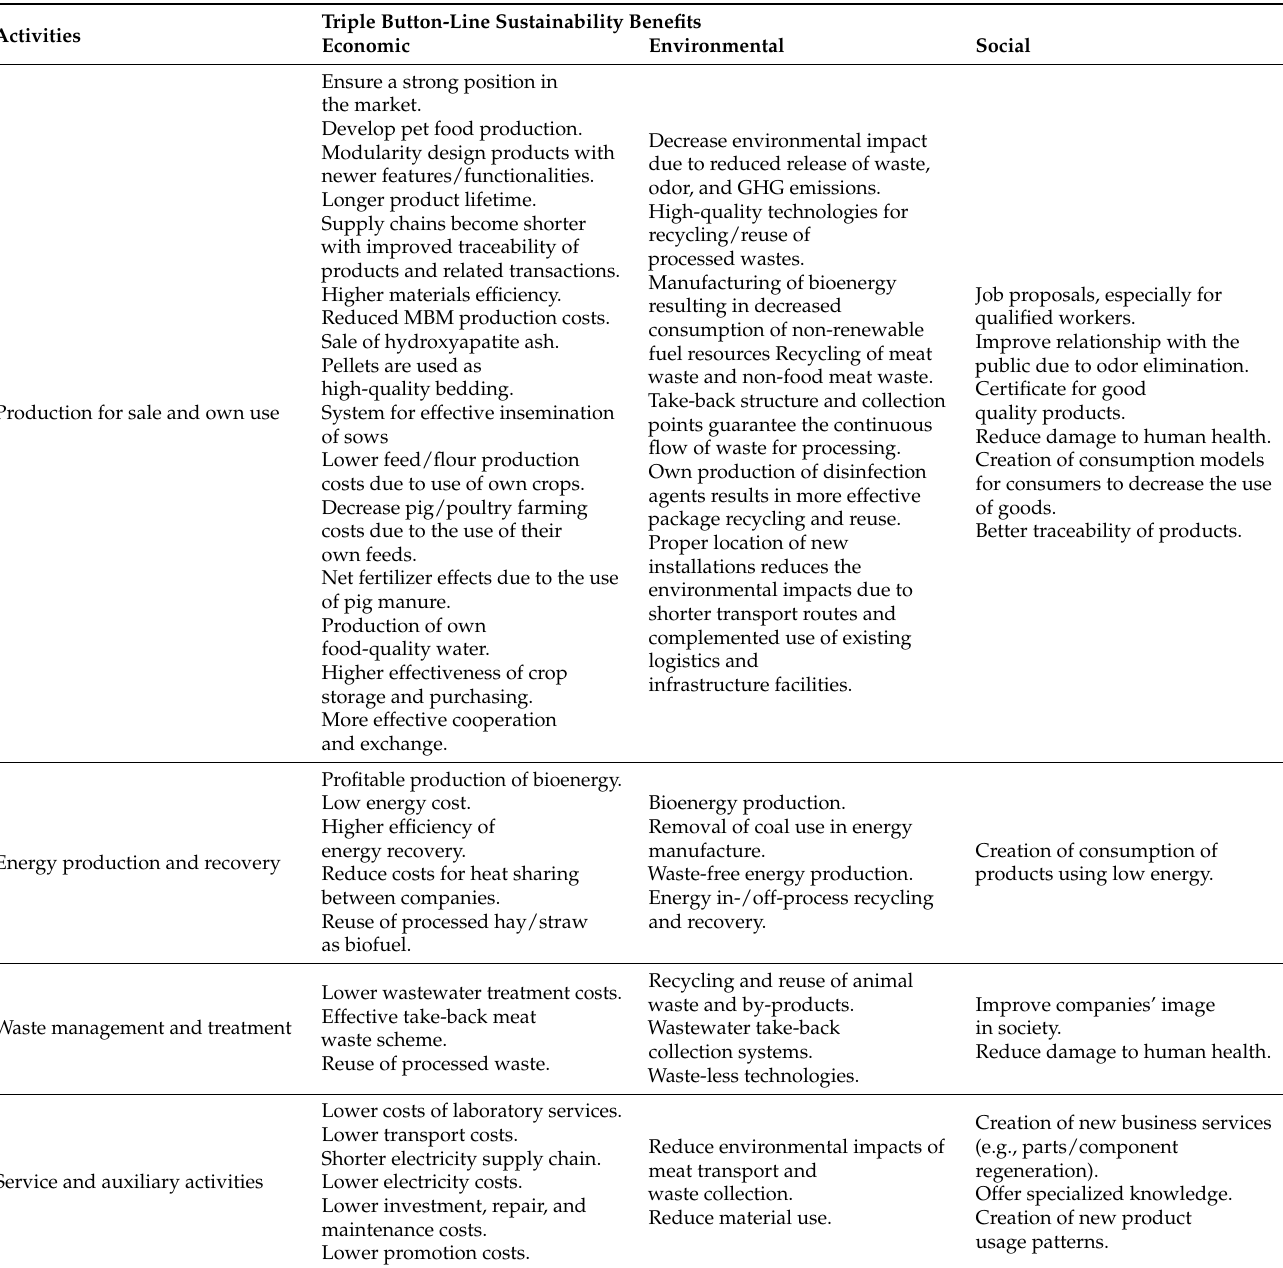
Table 4. Qualitative triple-button sustainability analysis of the strategic activities realized in ´Smiłowo